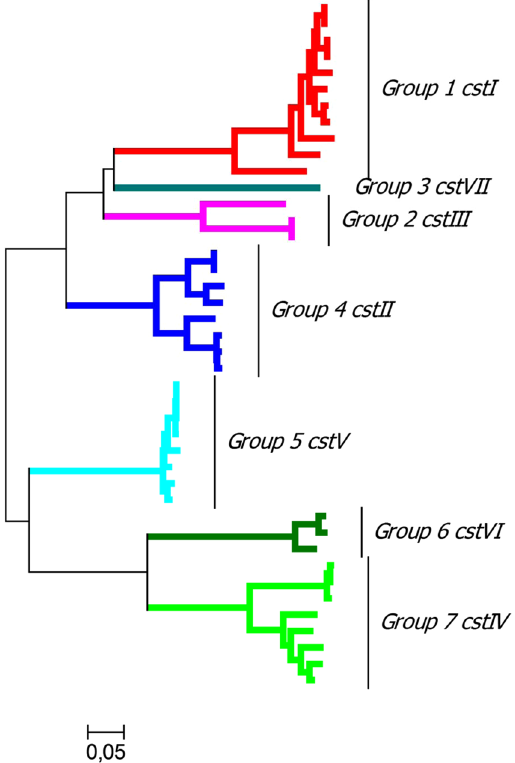
Figure 1. Evolutionary analyses of C . coli GT-42. Evolutionary analysis of 45 C . coli GT-42 sequences and three C . jejuni sequences ( cstI , cstII and cstIII ) was conducted in MEGA7 and the evolutionary history was inferred using the Minimum Evolution method calculating the distance using Maximum Composite Likelihood. The tree is drawn to scale, with branch lengths in the same units (number of base substitutions per site) as those of the evolutionary distances used to infer the phylogenetic tree.